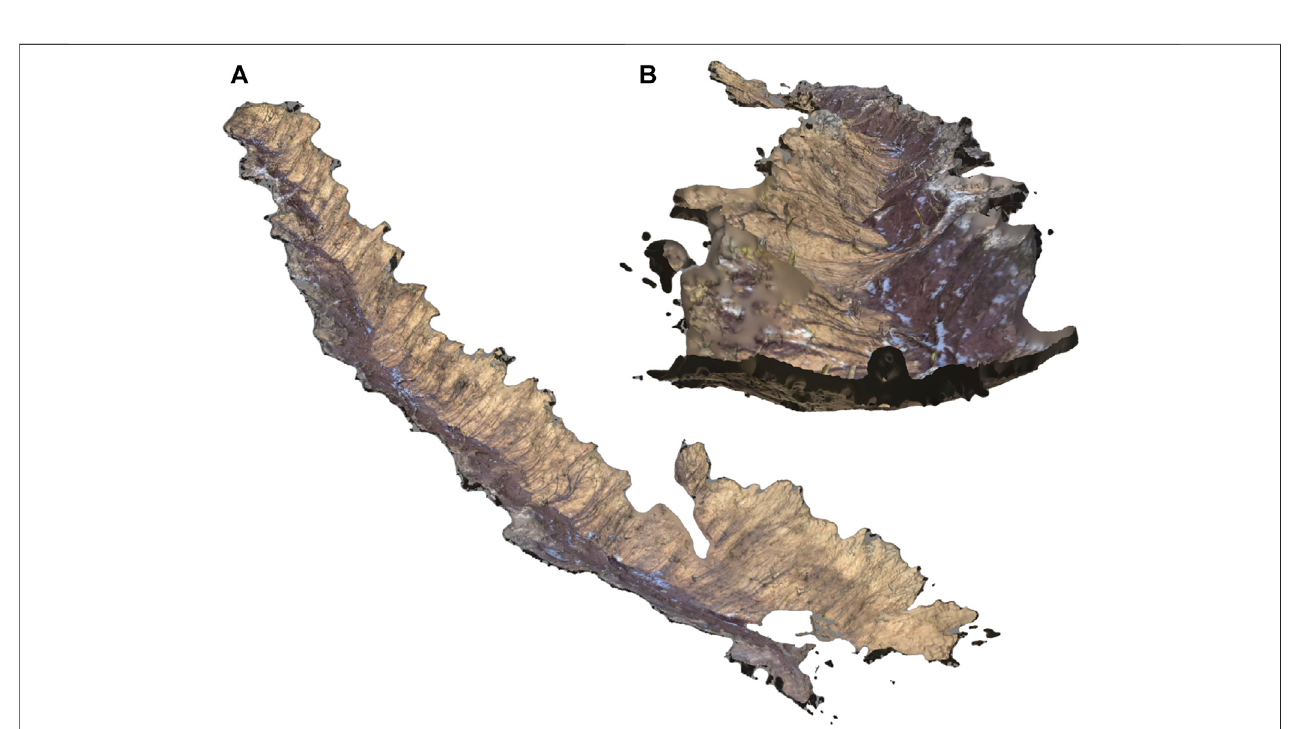
FIGURE5| Perspectiveviewof3Dmesh200 mTPSmodelofthegully(withajunctionwithleft,smaller,tributarygully) (A) andaviewfromthewest(highest)point- of-view (B) .